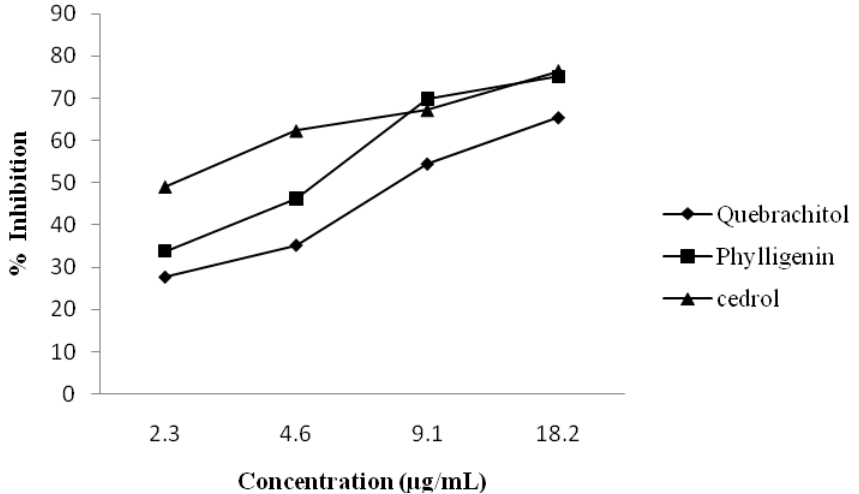
Figure 2. Inhibitory effect of phylligenine, quebrachitol and cedrol on 3 H-PAF binding to receptor on rabbit platelets at various concentrations. Each point represents the mean of three experiments, each in triplicate. Standard deviation of the mean are indicated as vertical